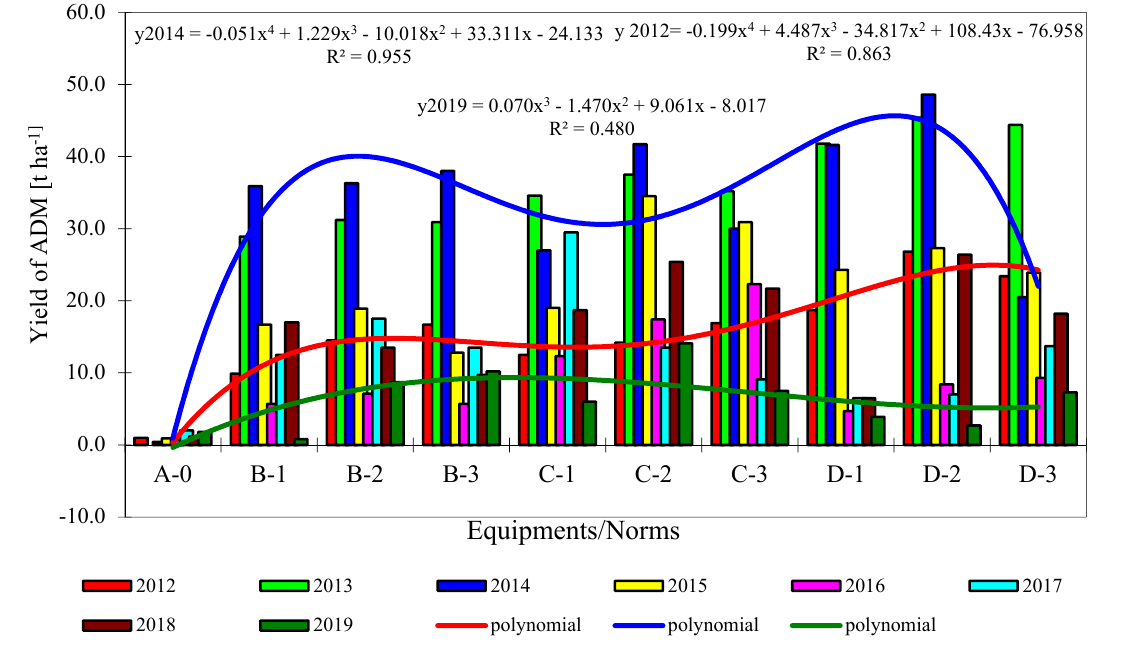
Figure 7. The share of T. repens in ADM of 1st pasture rotation (year 2012–2019). Tillage treatments: A—control object (without overseeding), B—underseeding after heavy tine harrow, C—underseeding after disc harrow, D—underseeding after the rotary tiller.